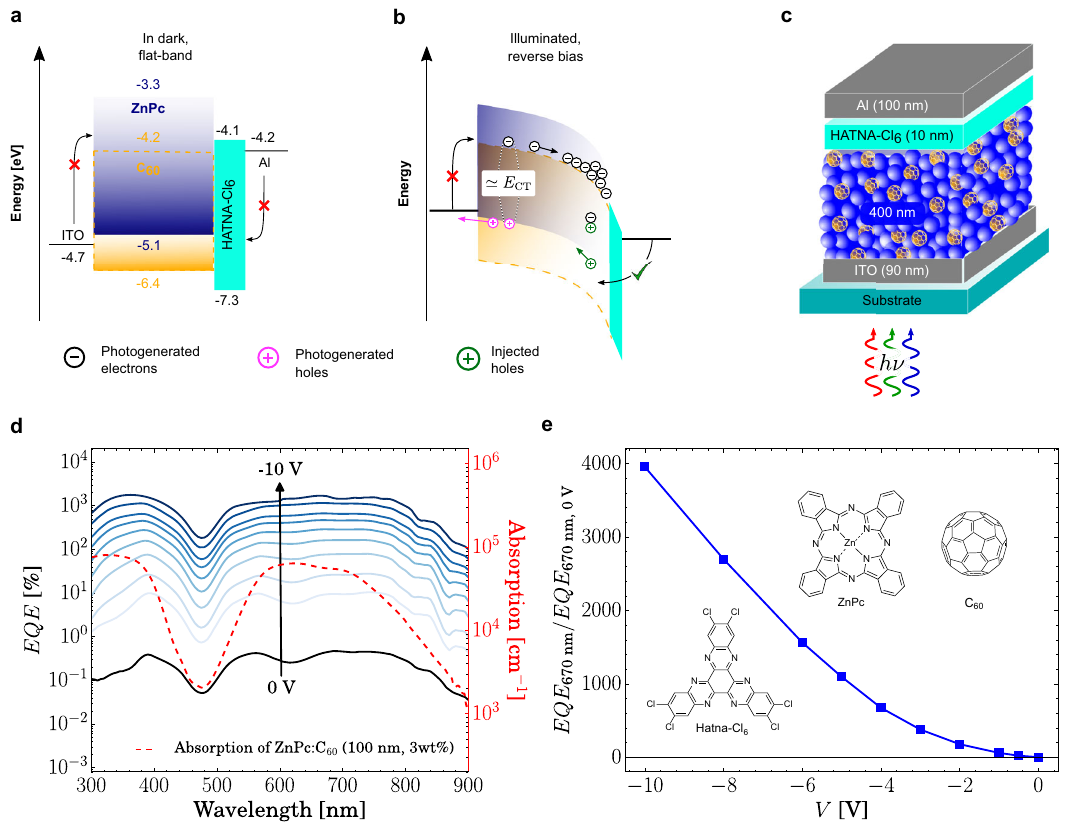
Fig. 1 Operation, device structure, and EQE of a PM-OPD. Schematic energy diagram a under dark at fl at band condition and b negatively biased under illumination. c schematic device structure. d Voltage-dependent EQE (solid lines) of the device shown in c comprising ZnPc blended with C 60 at 3 wt%. Each line corresponds to one symbol in d . Dashed red line shows the absorption spectrum of the same blend. Additionally, in e , the relative enhancement factor as a function of applied reverse bias is presented. Symbols show the ratio between EQE at 670 nm at each voltage from d normalized by the EQE at 670 nm at 0 V. The blue line is a guide to the eye. Note that no saturation is observed, indicating that EQE can be further increased. Inset shows the chemical structure of C 60 , ZnPc and HATNA-Cl 6 . The energy level values of ZnPc, C 60 , and HATNA-Cl 6 in a are taken from the literature 55 – 57 achieved in this system and how this effect can be used in nar- rowband PM-OPD.